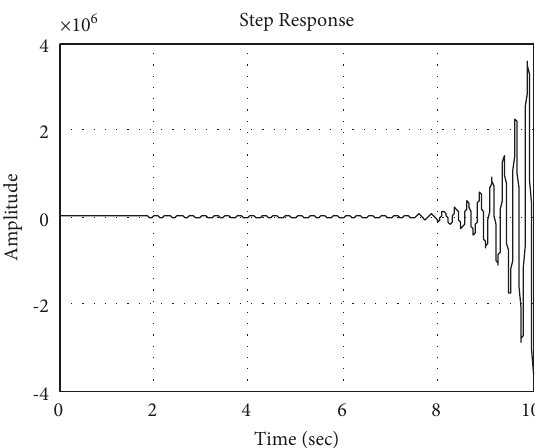
Figure 27: Response curve at 10 times β